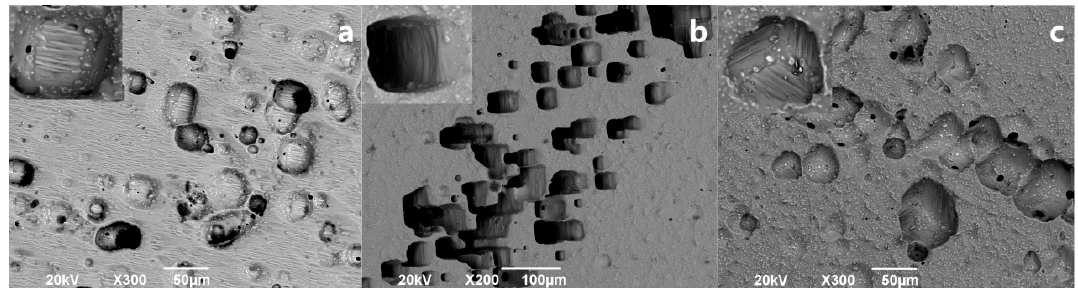
Figure 2. Corrosion patterns on different crystal directions after four days: ( a ) (100); ( b ) (110), and ( c ) (111).